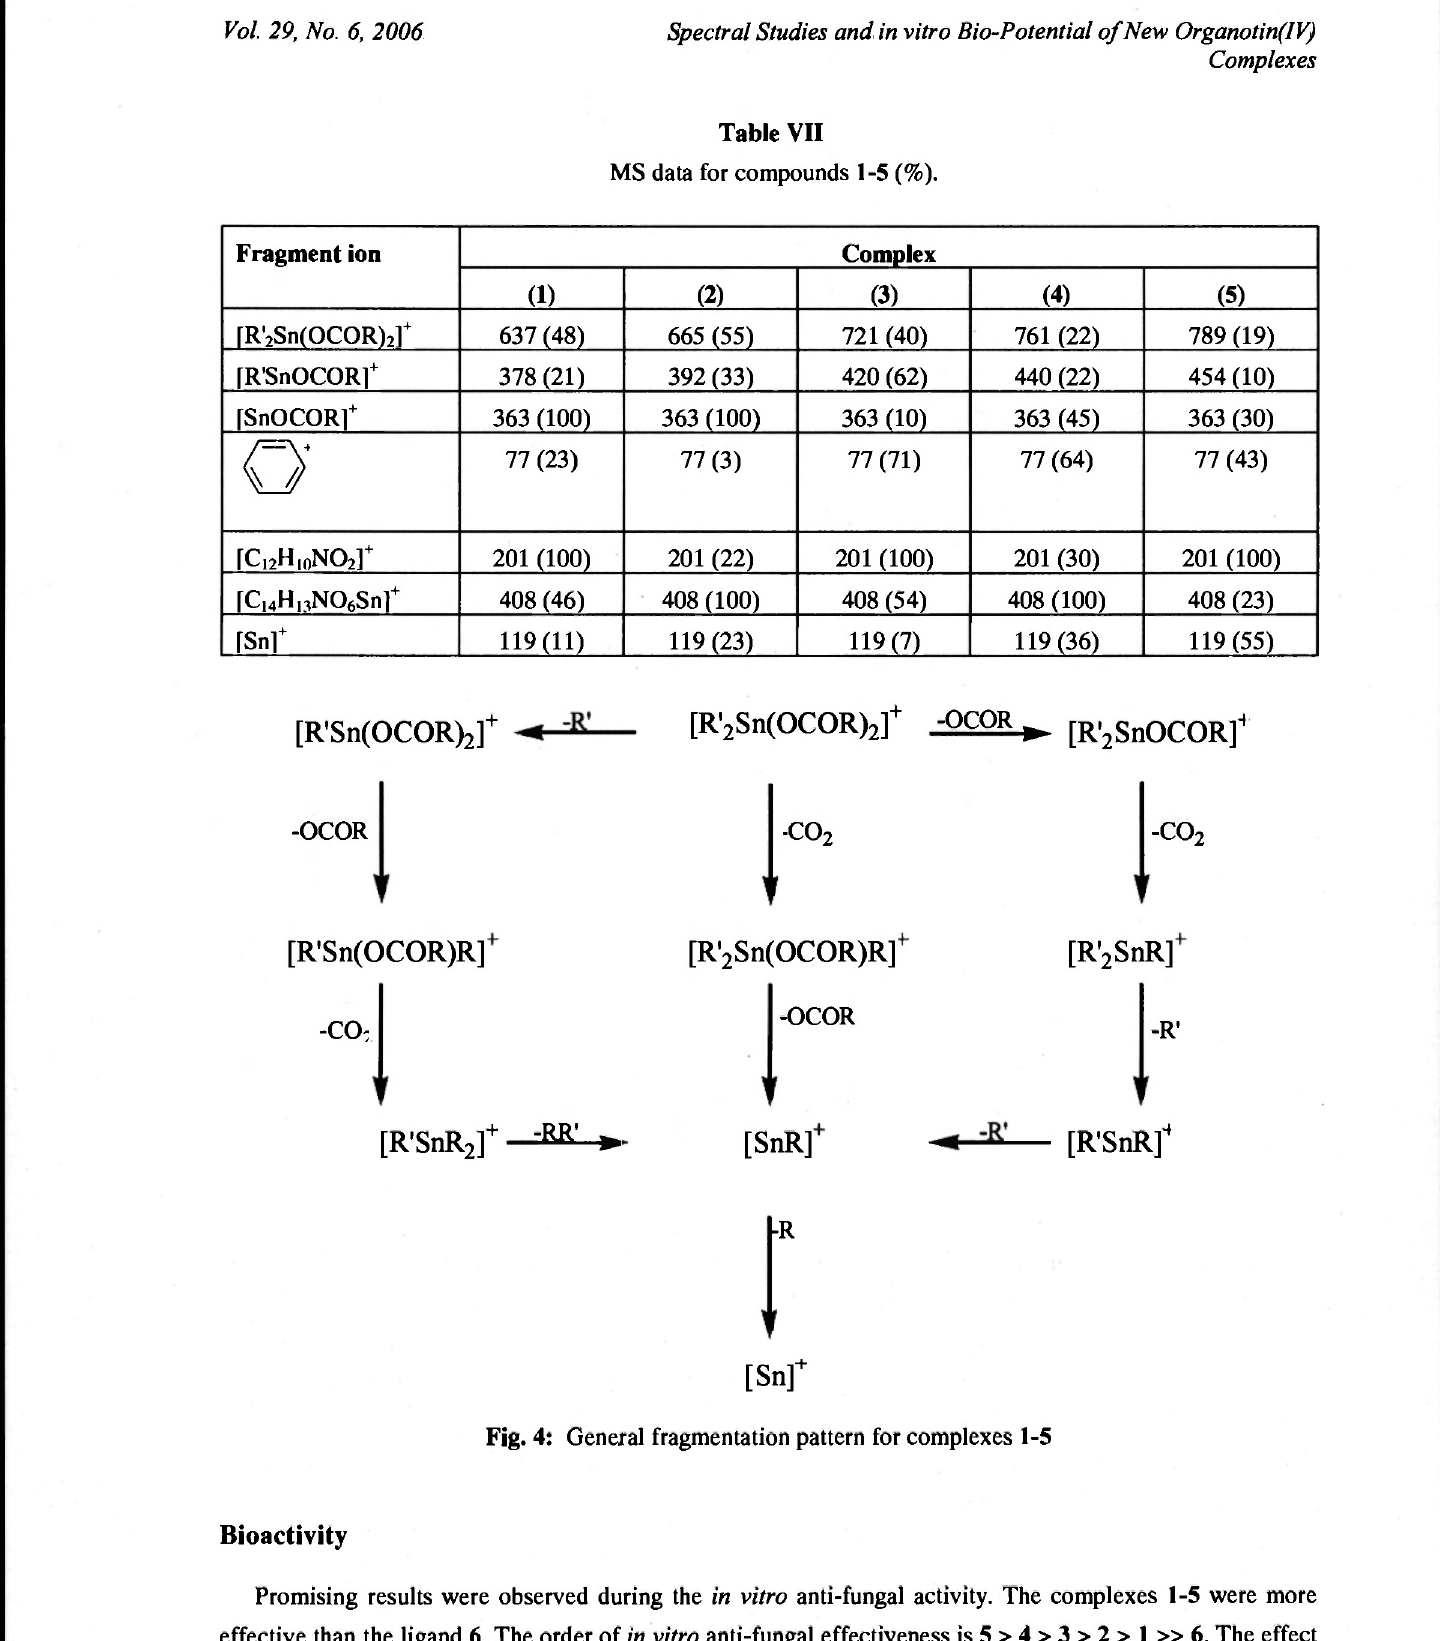
MS data for compounds 1-5 (%).